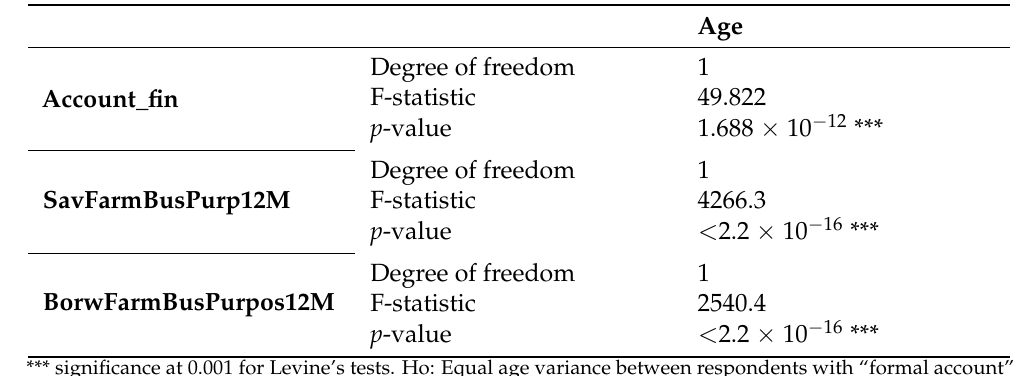
Table A4. Levine’s Test for homogeneity in groups’ variances in the model with formal account ownership, saving and borrowing for Entrepreneurial (Farming or Business) purposes.